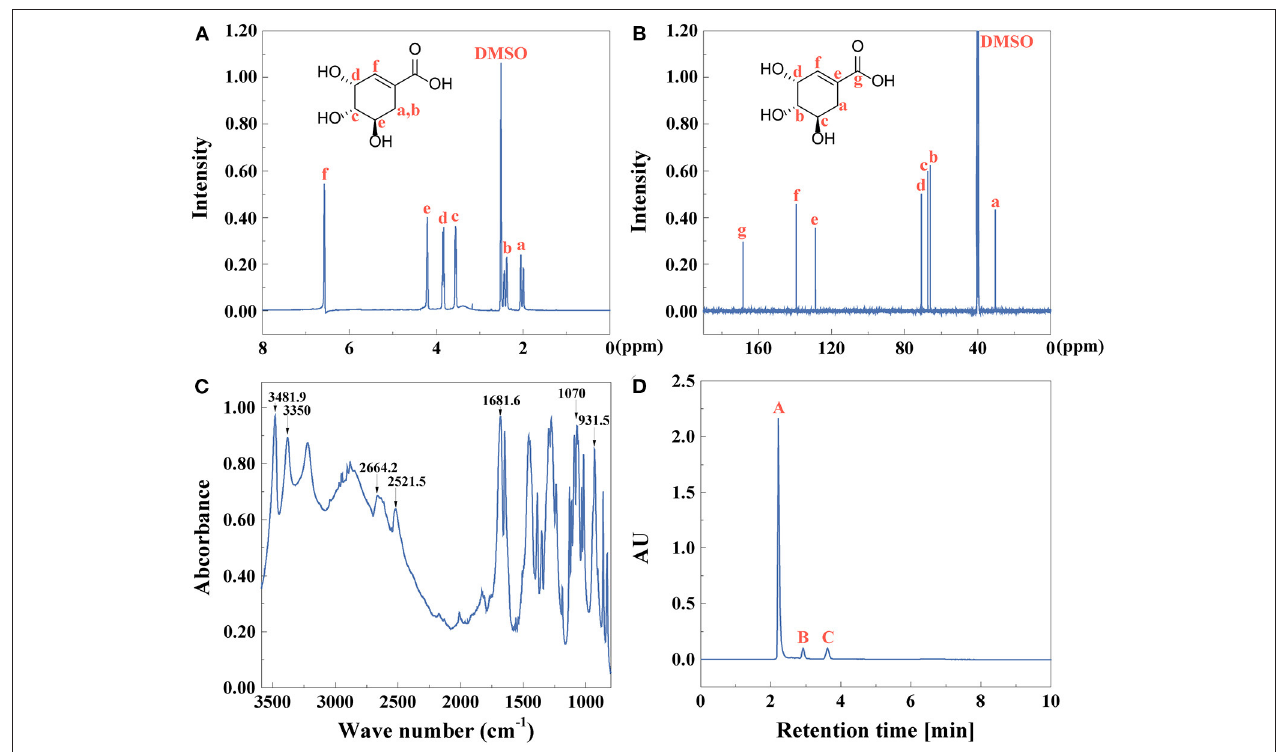
were assigned to C-H or C = C of alkene (Andayany et al., 2019). The peaks at 1,071 and 1,058 cm − 1 or 1,274 and 1,253.5 cm − 1 were ascribed to symmetrical stretching vibration or asymmetrical stretching vibration of C-O-C (Yeoh et al., 2015). These results indicated that the methyl shikimate was obtained by the two catalysts. that the 201 nm ( Supplementary Figure 3A ) compared to shikimic acid at 205 nm ( Supplementary Figure 2A ) due to the conjugated double bonds C = C-C = O. The fluorescence spectra of methyl shikimate catalyzed by both SOCl 2 and solid acid were shown in Supplementary Figures 3B,C , respectively.